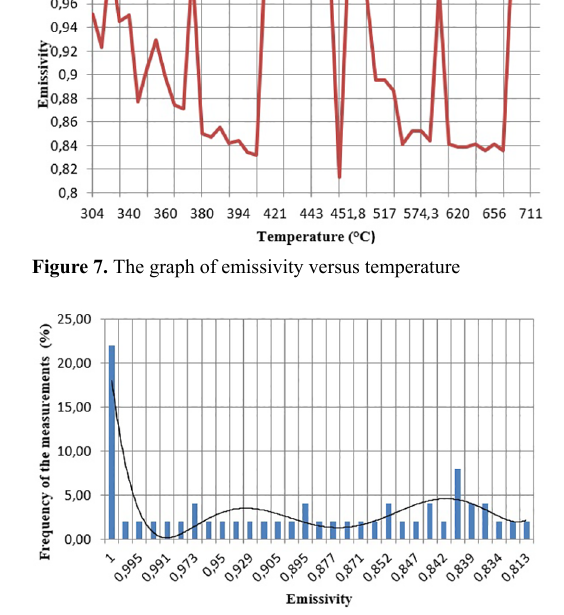
Figure 8. Graph of the emissivity statistic